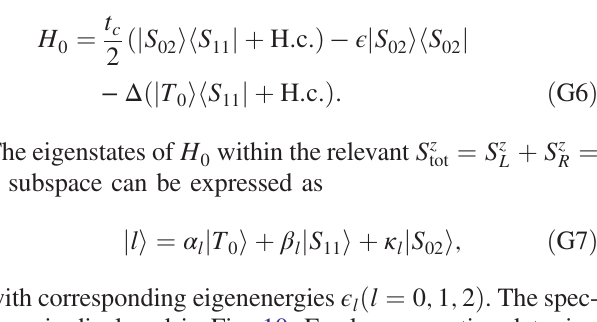
FIG. 9. Illustration of the relevant electronic levels under consideration. The triplet levels with S z resonance by applying a sufficiently large homogeneous mag- netic field.